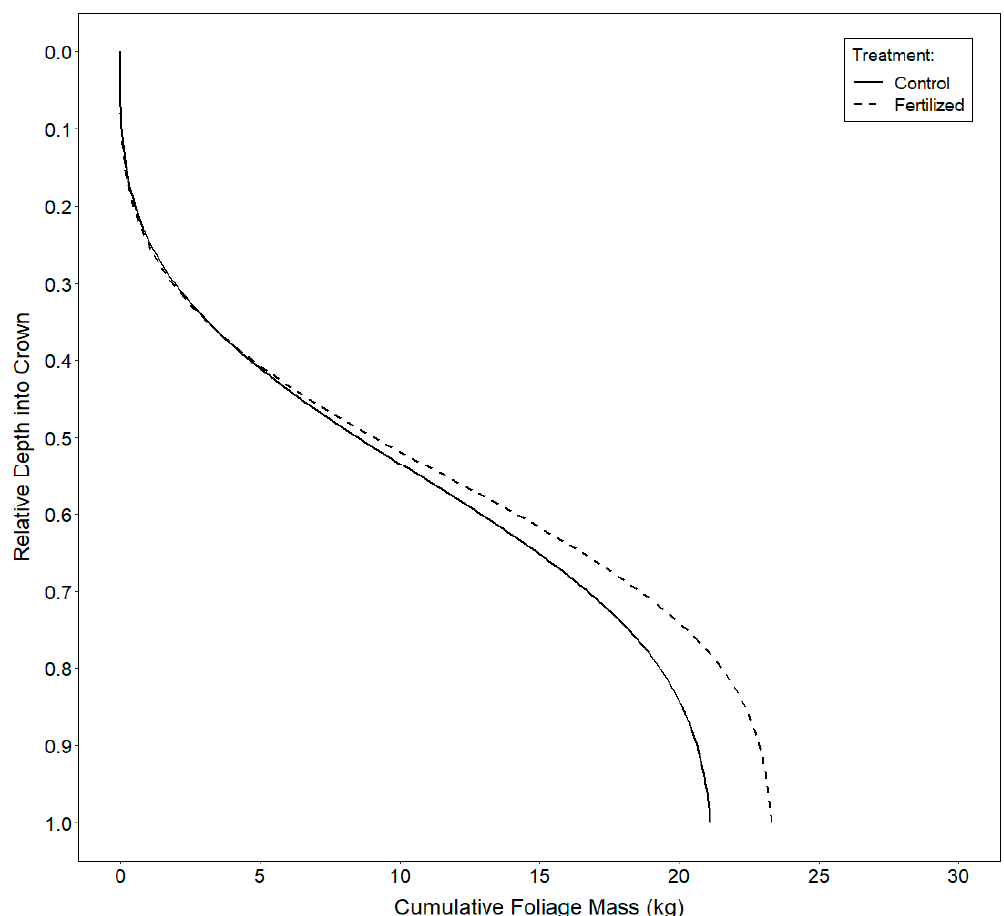
Figure 5. Cumulative distribution of foliage (kg) over relative depth into crown (RDINC) estimated from a right-truncated Weibull distribution (control = solid line; fertilized = dashed line). Distributions were standardized to average tree size in the study (D = 27.50 cm; H = 20.76 m; HCB = 7.28 m; CL = 13.48 m). RDINC = 1 at crown base and RDINC = 0 at tree tip.